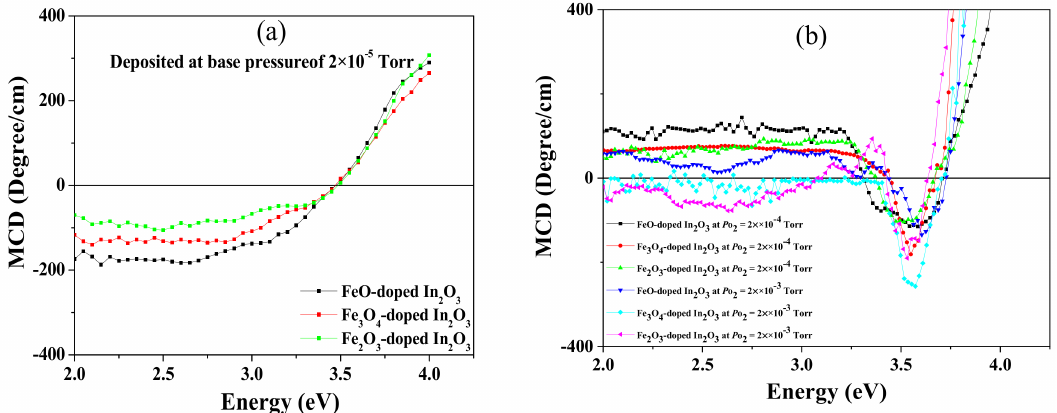
Figure 7. Magnetic circular dichroism (MCD) spectral shapes of the Fe-doped In 2 O 3 samples deposited from di ff erent precursors at ( a ) base pressure and ( b ) at 2 × 10 − 4 Torr shown with black, red and green symbols for FeO, Fe 3 O 4 and Fe 2 O 3 , respectively and at 2 × 10 − 3 Torr with blue, turquoise and pink symbols for FeO, Fe 3 O 4 and Fe 2 O 3 ,